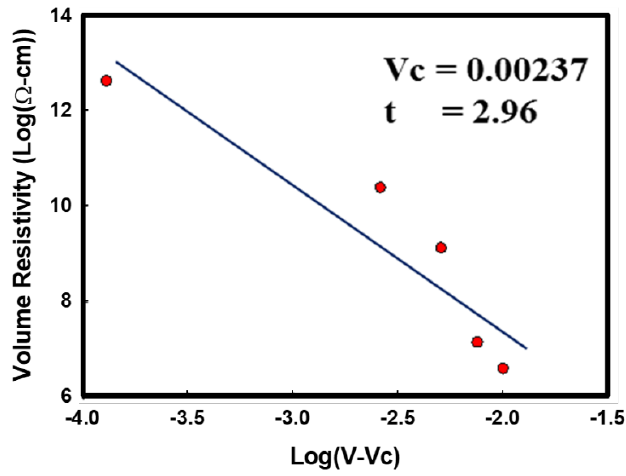
Figure 11. The electrical percolation threshold of CuNWs for i-PP/CuNWs composites. Power law equation: